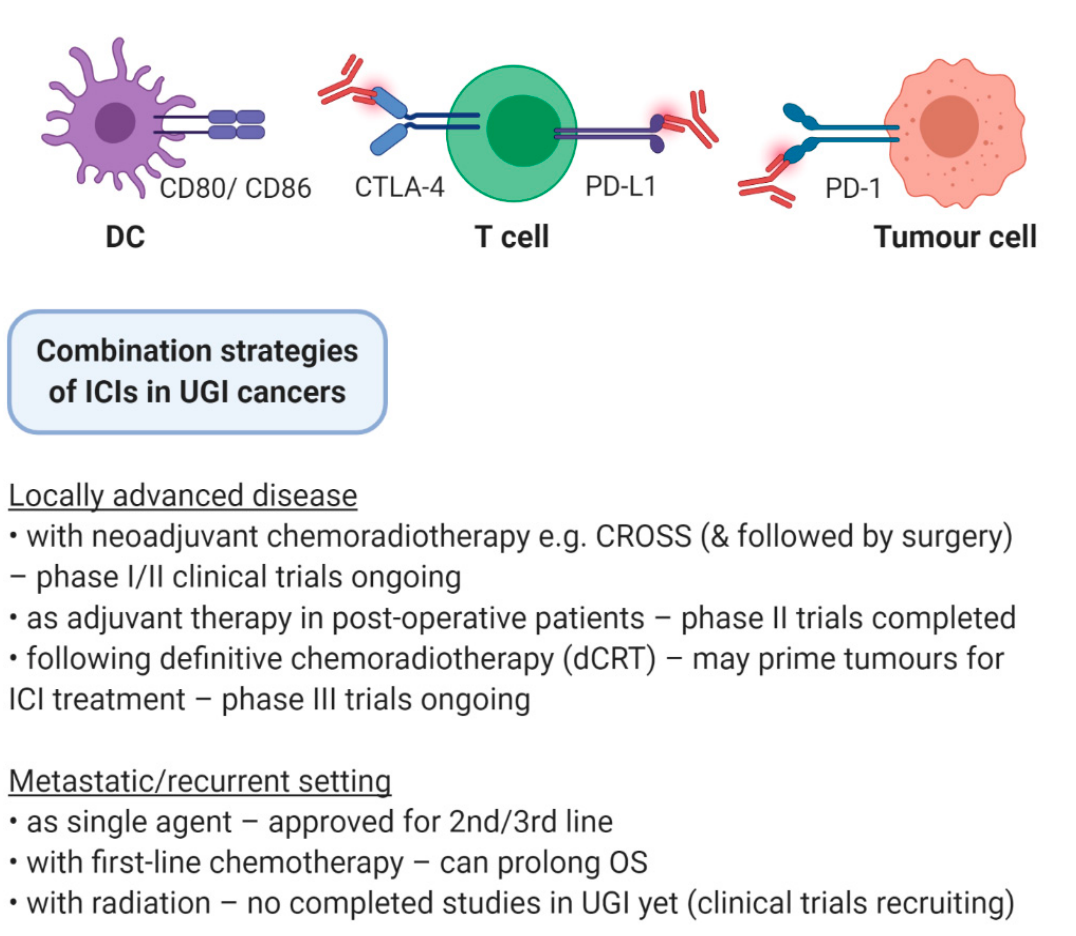
Figure 1. Combination strategies of ICIs in UGI cancers. Immune checkpoint inhibitors (ICIs) are under investigation in a variety of settings in upper gastrointestinal (UGI) cancers, including in conjunction with surgery, chemotherapy, radiation therapy, and multimodal combinations.